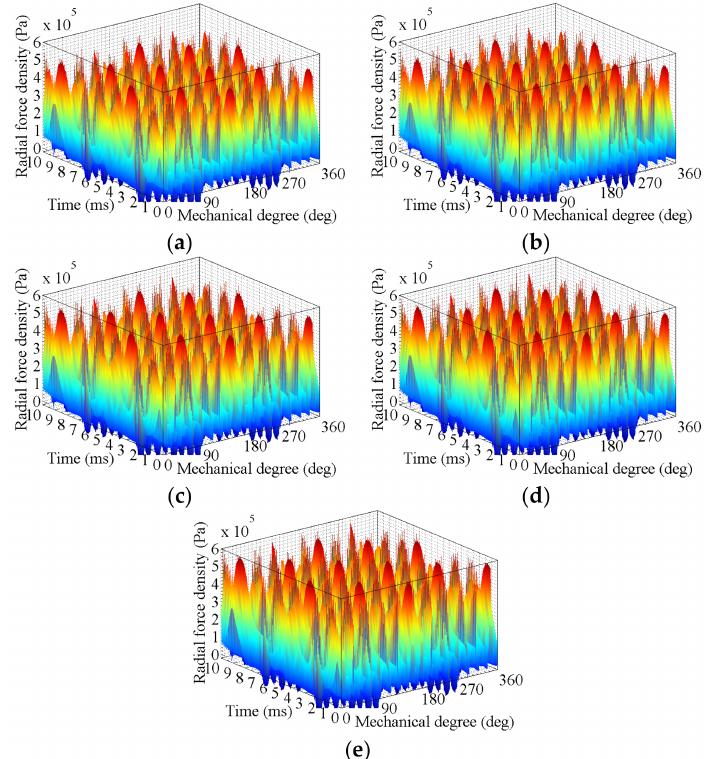
Figure 14. Radial force density in the IPMSM with rotor deformation at high-speed load condition.